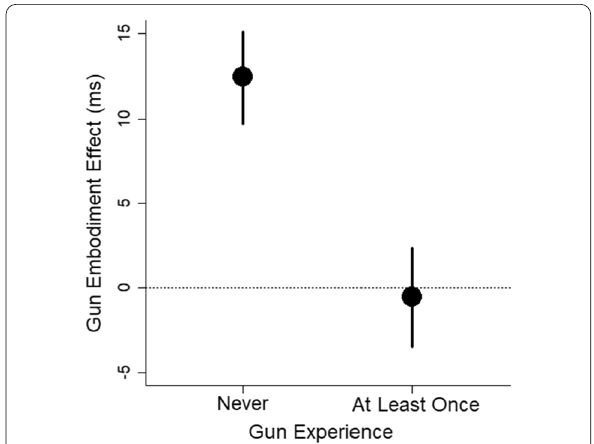
Fig. 10 Mean gun embodiment effect (measured with reaction time) is plotted as a function of prior gun experience. Error bars are 1 SEM